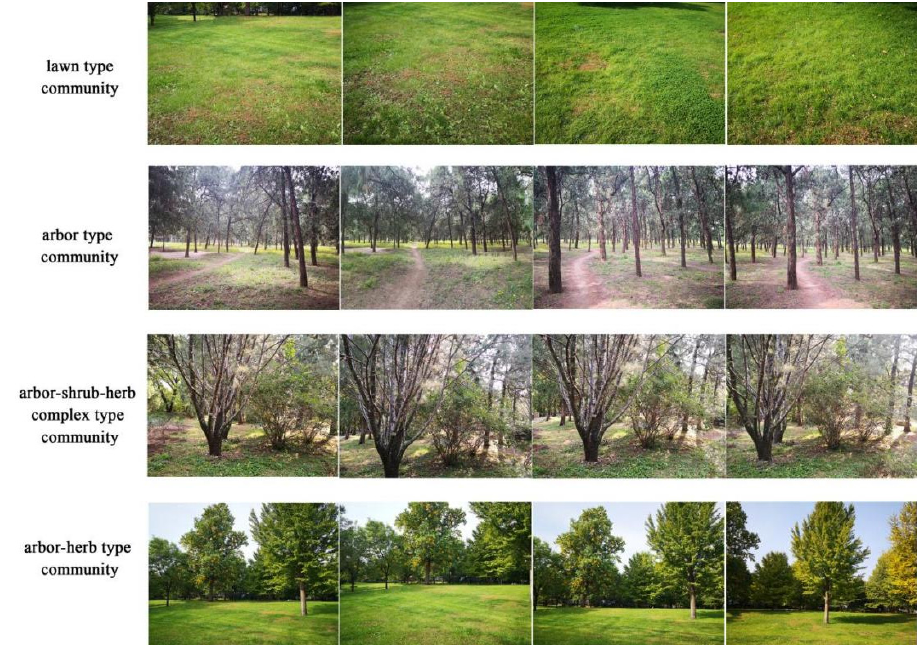
Figure 4. Two-dimensional color photographs of the selected study